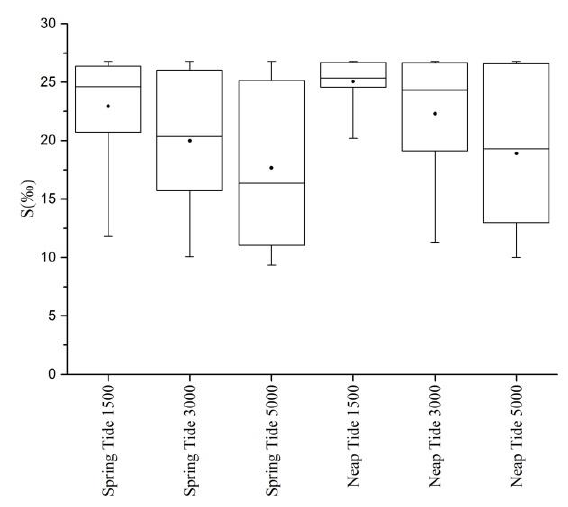
Figure 9. Salinity fluctuation in aquaculture area under different opening schemes.